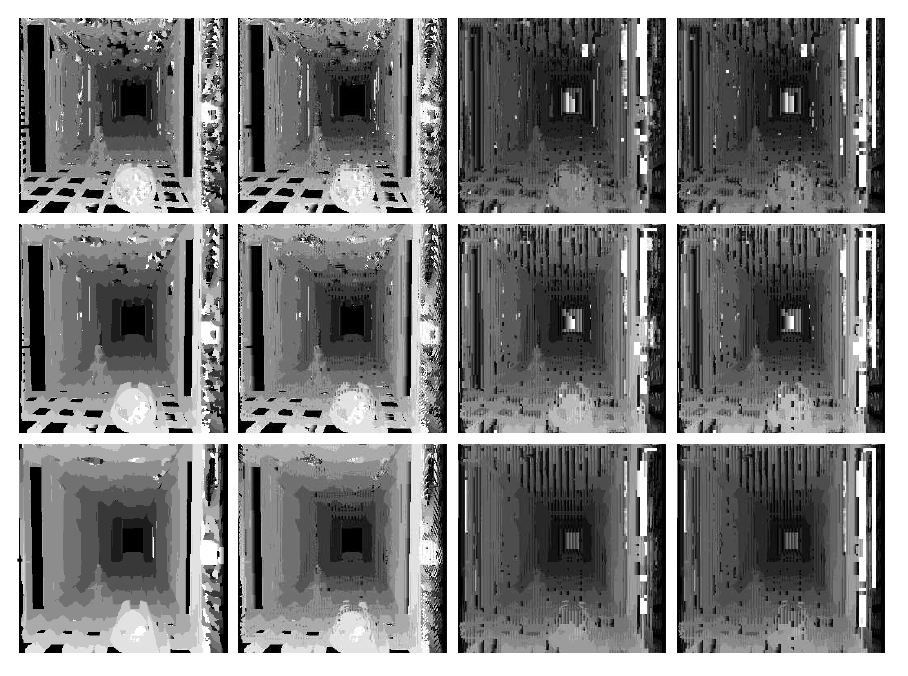
Figure 16. Disparity maps generated, Corridor, by generated by correlation (right column) and multiresolution matching multiresolution matching with δ ∈ { 0 , 0 . 1 , 0 . 2 } (columns from